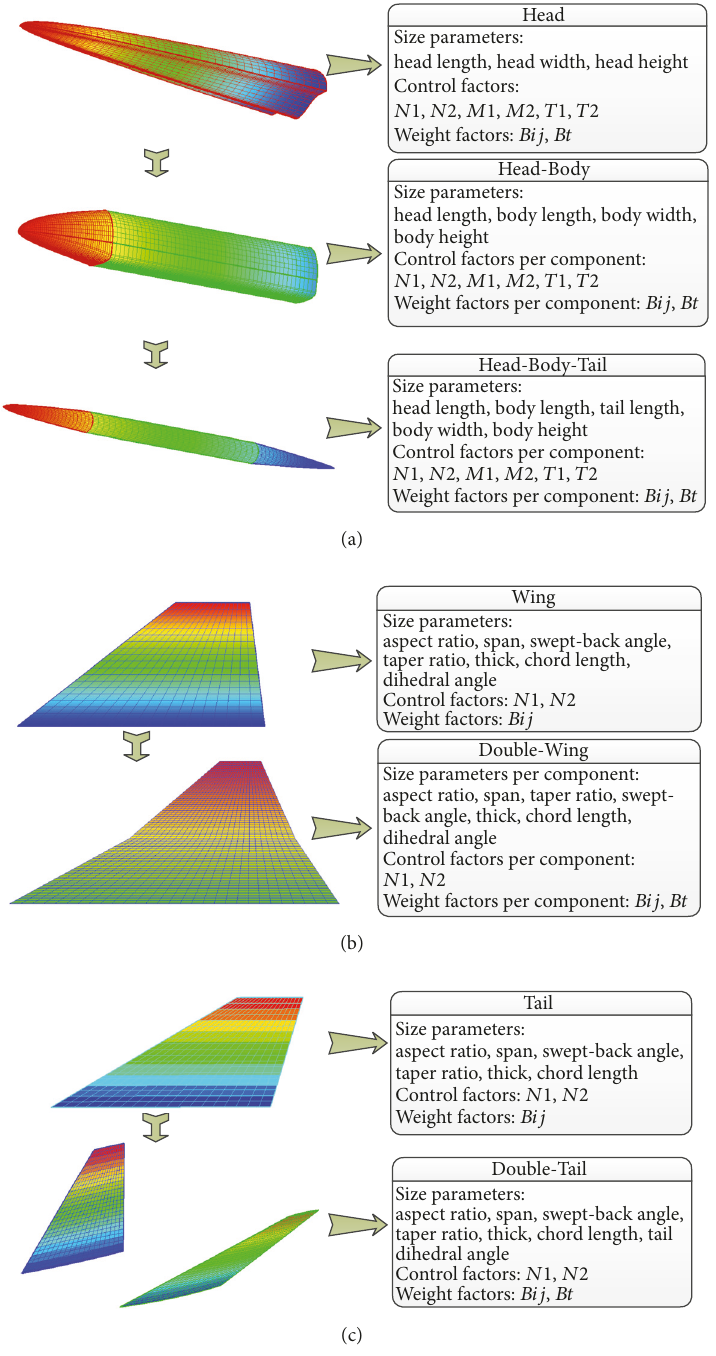
Figure 2: Basic components in the aircraft characteristic components